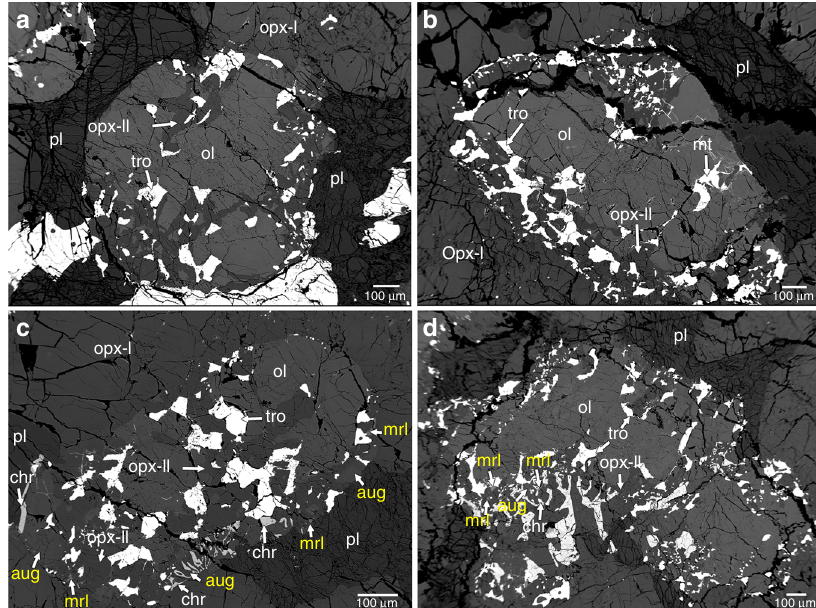
Fig. 2 Backscattered electron images showing the replacement texture of olivine in NWA 8321. a , b Troilite and orthopyroxene form at the margin and in interior of an euhedral olivine grain. Note FeNi metal is also closely associated with troilite and orthopyroxene in ( b ). c , d Fine-grained augite, chromite, and merrillite are present, surrounding the olivine grains. ol: olivine; pl: plagioclase; aug: augite; mrl: merrillite; chr: chromite; opx: orthopyroxene; tro: troilite; mt: